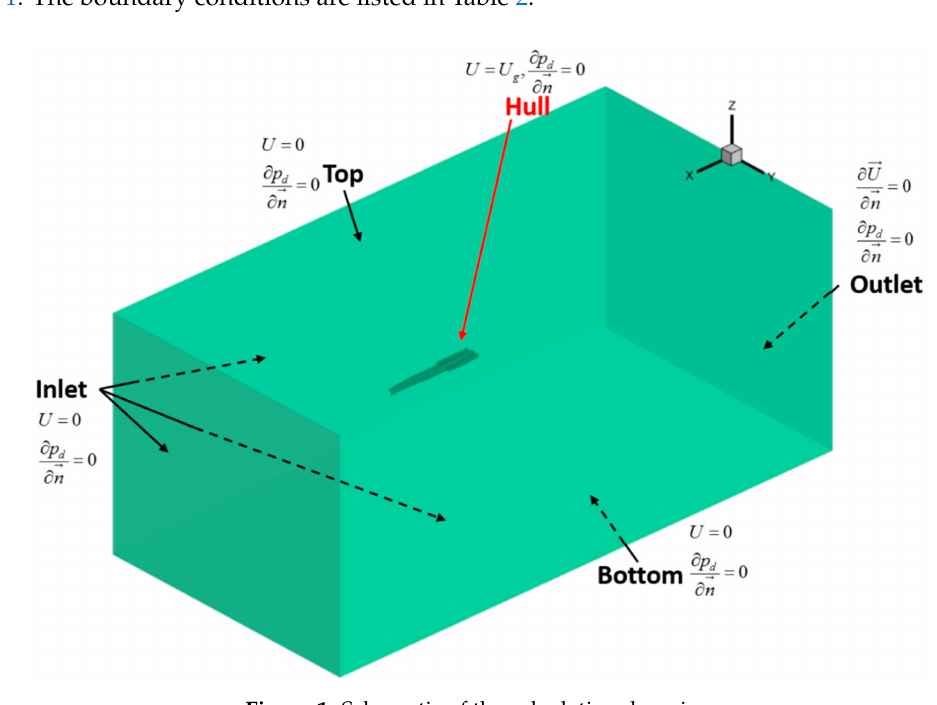
Figure 1. The boundary conditions are listed in Table 2.